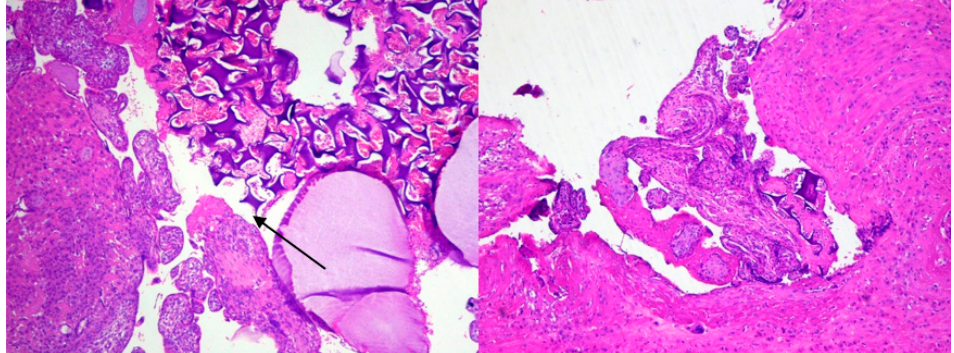
Figure 6. The placental villi, fragment of decidua, and foreign body. (H&E stain, 4×). The uterus wall from the area of the scar after caesarian section. Chorionic villi attach to the muscular layer of the uterus wall (absent decidua basali) and fragment of foreign body (arrow). (H&E stain, 4×). In the scar area, pieces of soluble threads after previous CS were found.